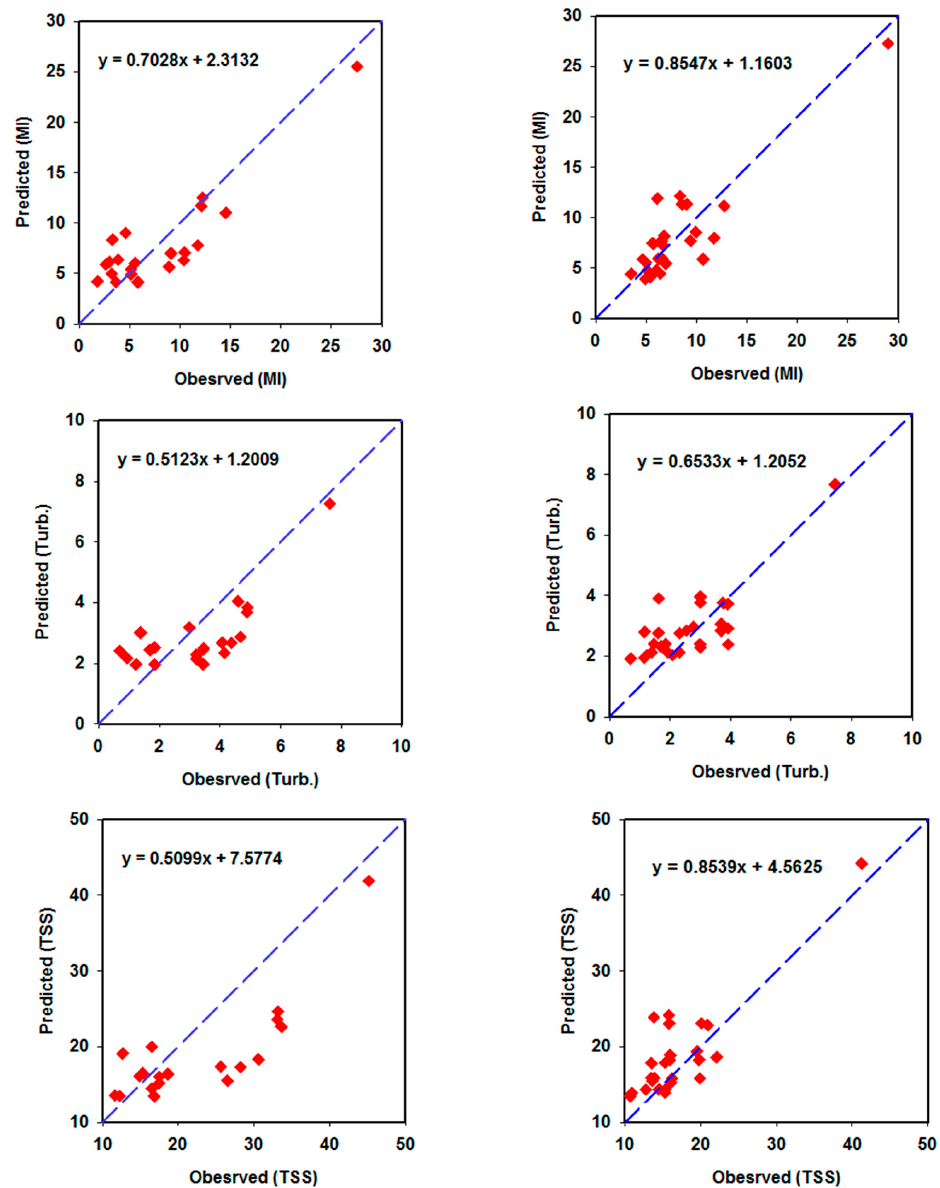
Figure 10. Association between observed and predicted validation models for drinking water quality index (DWQI), metal index (MI), turbidity (Turb.) and total suspended solids (TSS) for each river branch using the PLSR based on selected SRIs. Statistical analysis including R 2 , p -value and RMSE is shown in Table